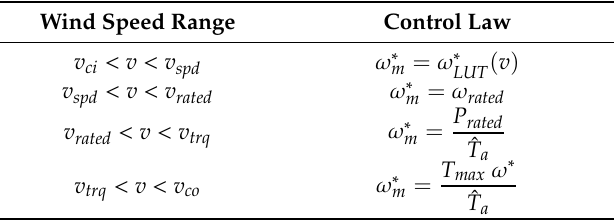
Figure 5. Subregions of the DHAWT operating range. Table 3. Shaft speed control